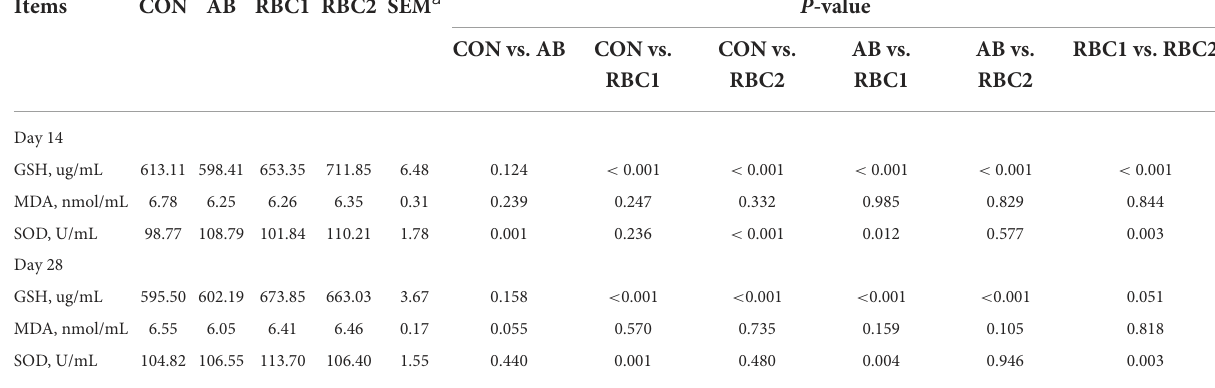
TABLE 7 Effect of dietary RBC and AB supplementation on serum antioxidant properties of weaning piglets.